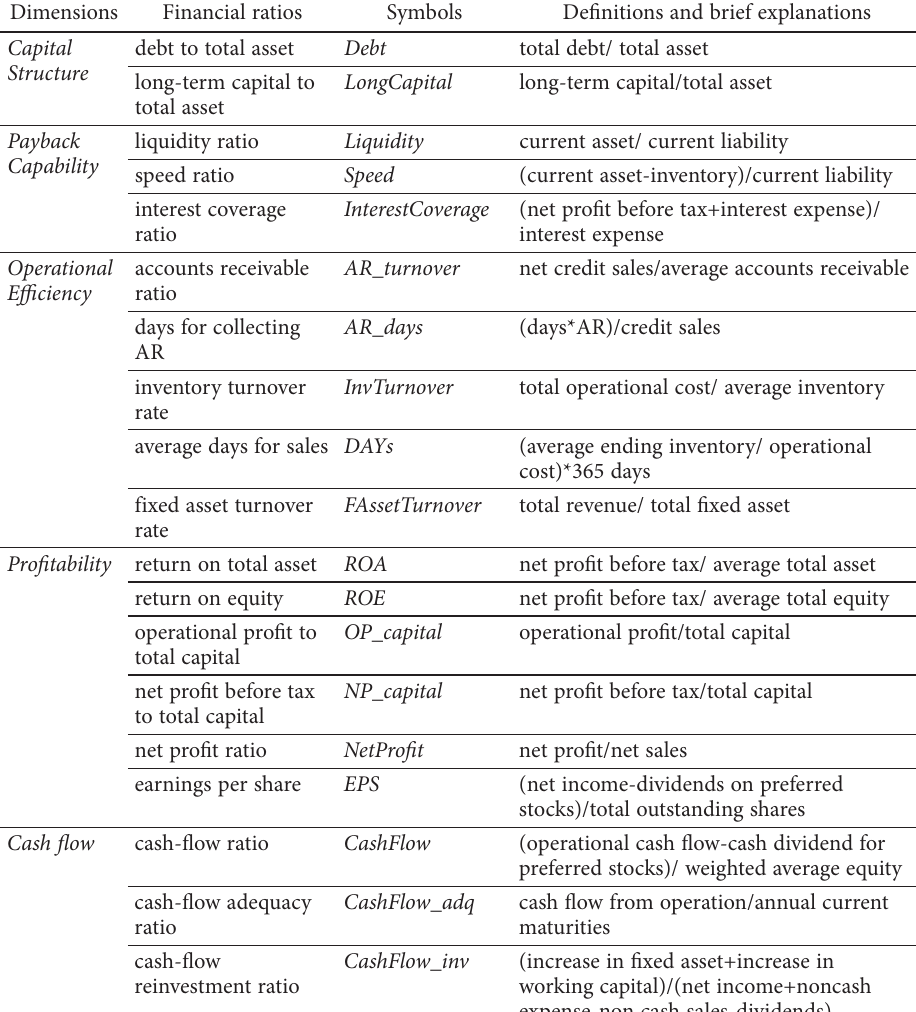
Table 1. Definitions of the 20 conditional attributes (financial indicators) Dimensions